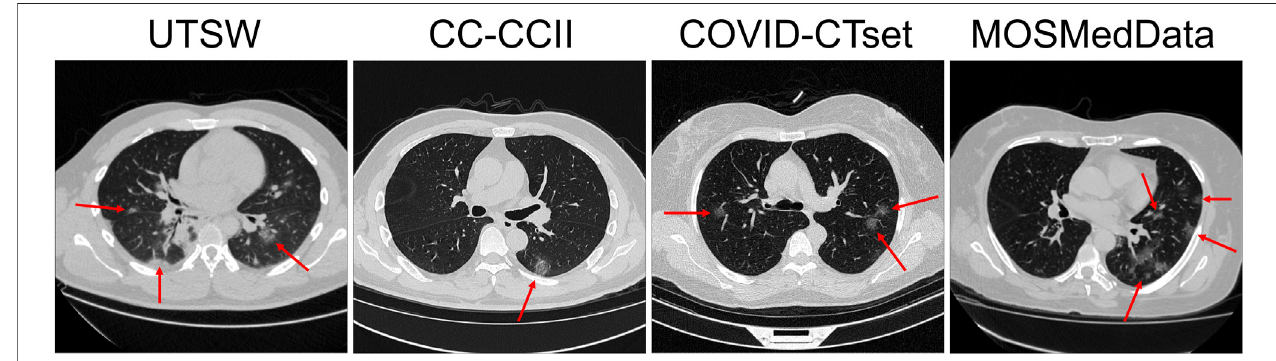
FIGURE 1 | Slice view of example CTs from each dataset. Red arrows show patchy ground-glass opacities with round morphology, which are typical fi ndings in COVID-19